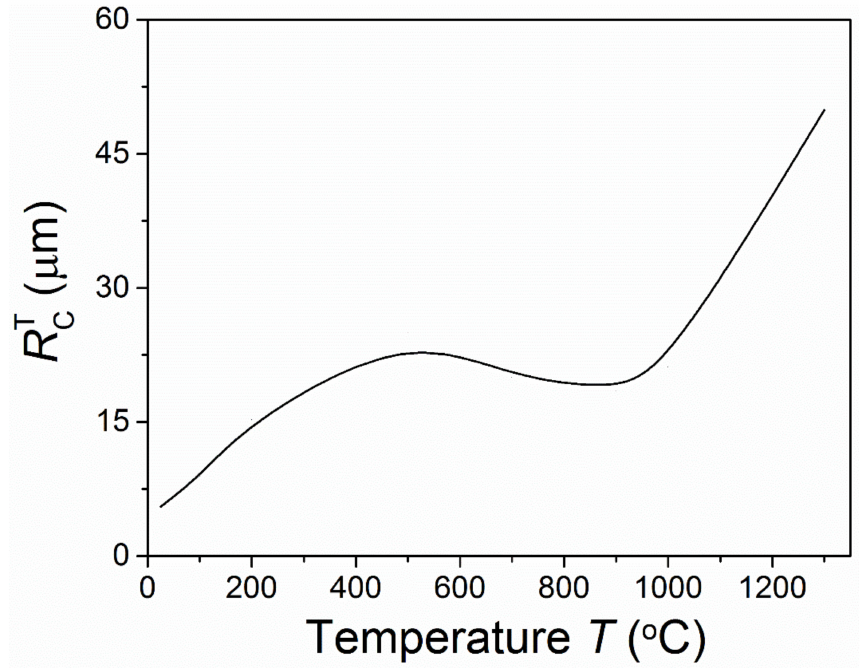
Figure 2. Temperature-dependent critical inclusion size for spontaneous